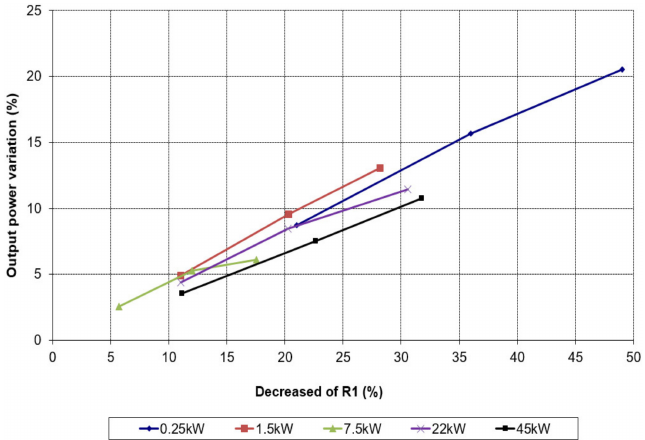
Figure 6. Output power variation versus decreased of R 1 in all the motors.